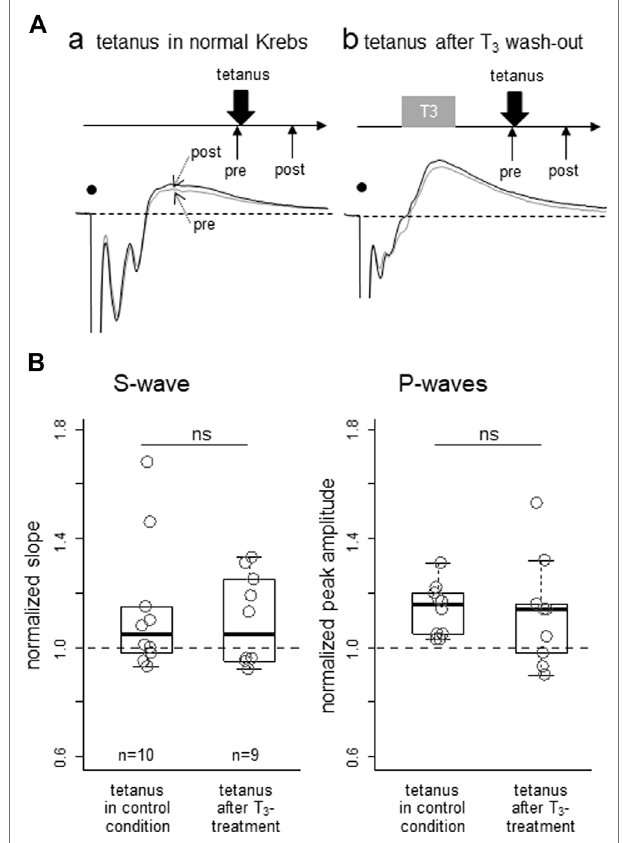
FIGURE 3 | Lack of T 3 effect on lasting potentiation of synaptic responsesafterlow-frequencytetanicstimulationappliedlocallyinIMM.Effect of T 3 pre-treatment on the subsequent induction of potentiation was examined. (A) Two examples of pre- (thin) and post-tetanus (thick) traces, one with T 3 pretreatment (Aa) and one without (Ab) ; ~30 successive responses at 10 s intervals (B) Normalized initial negative slope of the S1- wave(left)andnormalizedpeakamplitudeoftheearlyP-wavewerecompared between two groups, but no signi fi cant difference was